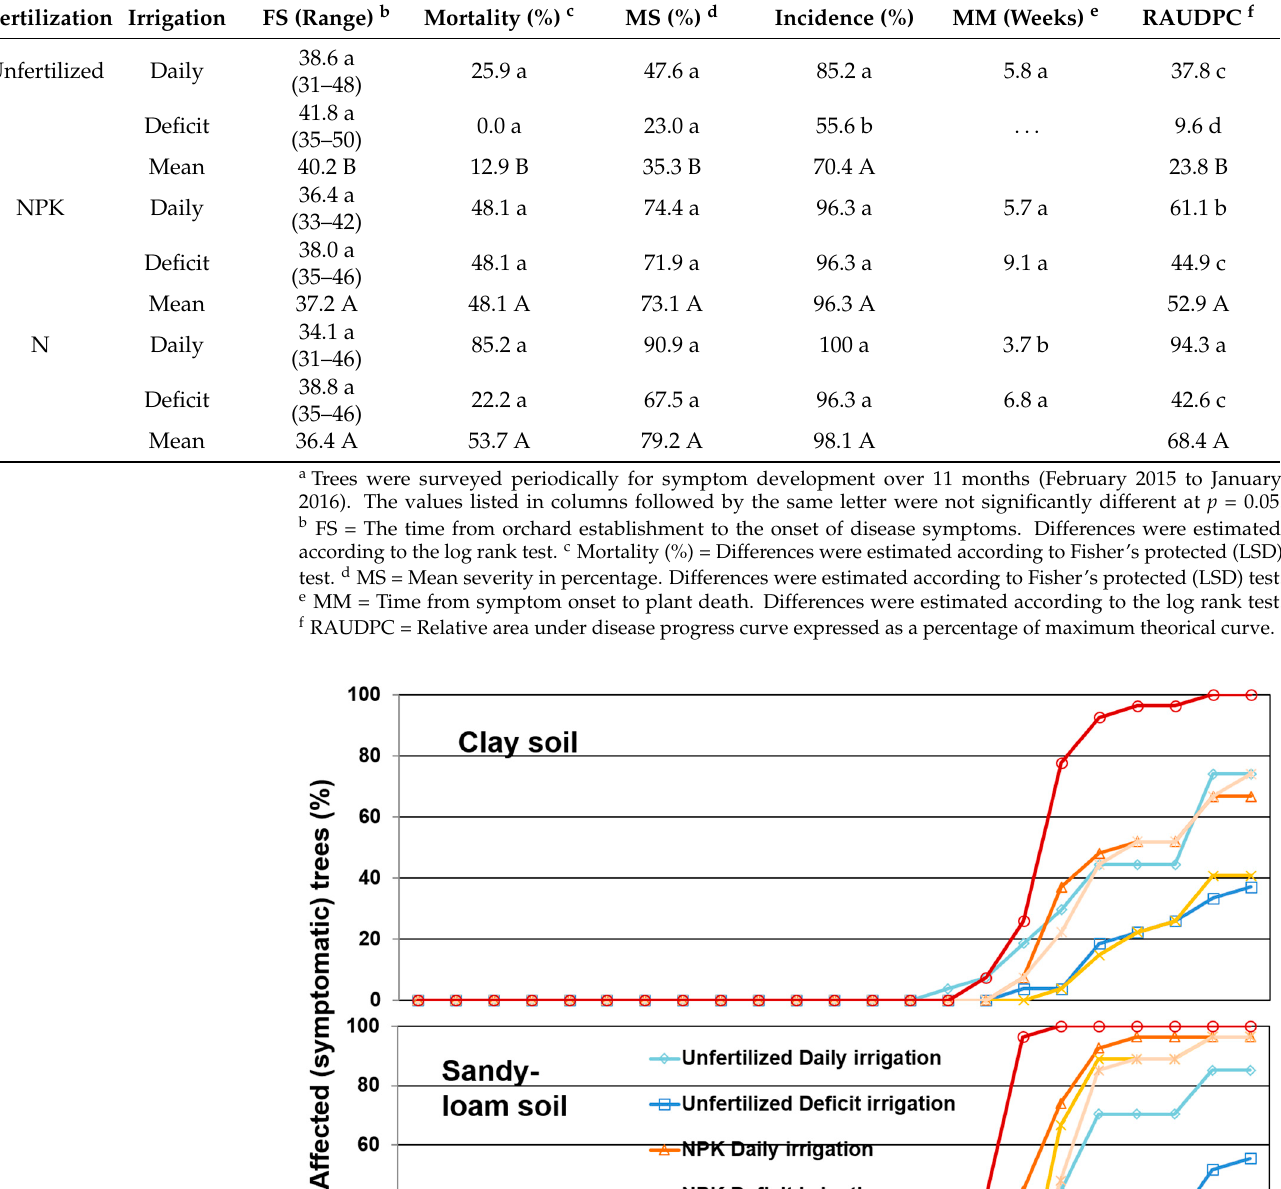
Table 2. Effect of fertilization treatments and irrigation frequency on the final estimated disease values for susceptible cultivar Picual in microplots of sandy-loam soil naturally infested by Verticillium dahliae a . Fertilization Irrigation FS (Range) b